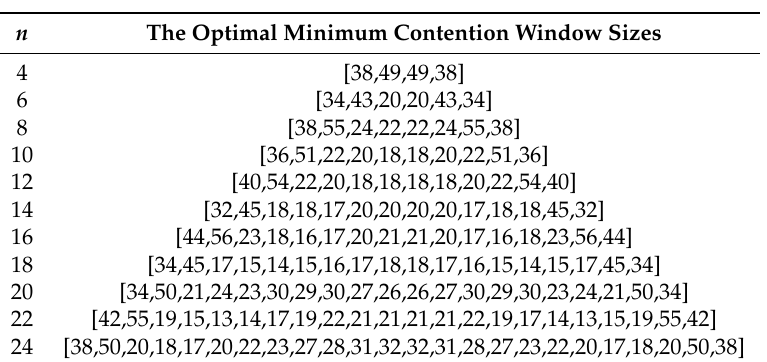
Figure 4. End-to-end delay vs. number of backbone vehicles. Table 2. The optimal contention window